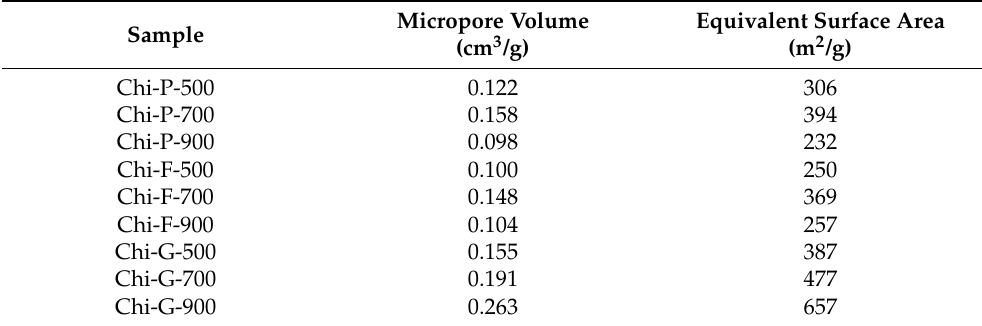
Table 1. Textural properties of biochars determined from CO 2 adsorption isotherms, as determined using the Dubinin-Astakhov equation [29].